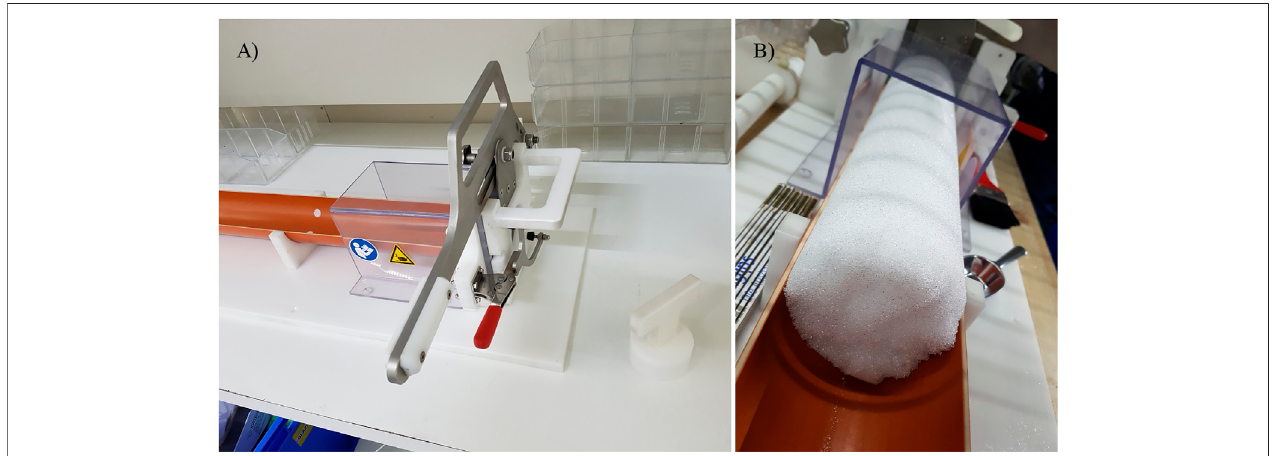
FIGURE3| Samplingdeviceforthesnowpro fi les (A) Frontpartofthesnowpro fi lecuttingdevicewithtrough(orange),bladewithhandle(metal),attachment(white synthetic material, hold in place by clamp with red handle), piston to cut the interior part of the snow pro fi le (B) Due to the sampling method and the cohesiveness of the snow the pro fi le remains as one piece, unless breaks or layers with high porosity occur.